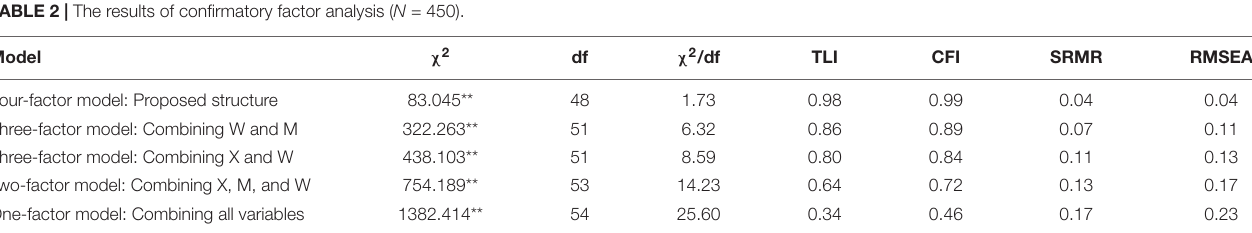
TABLE 2 | The results of confirmatory factor analysis ( N = 450).